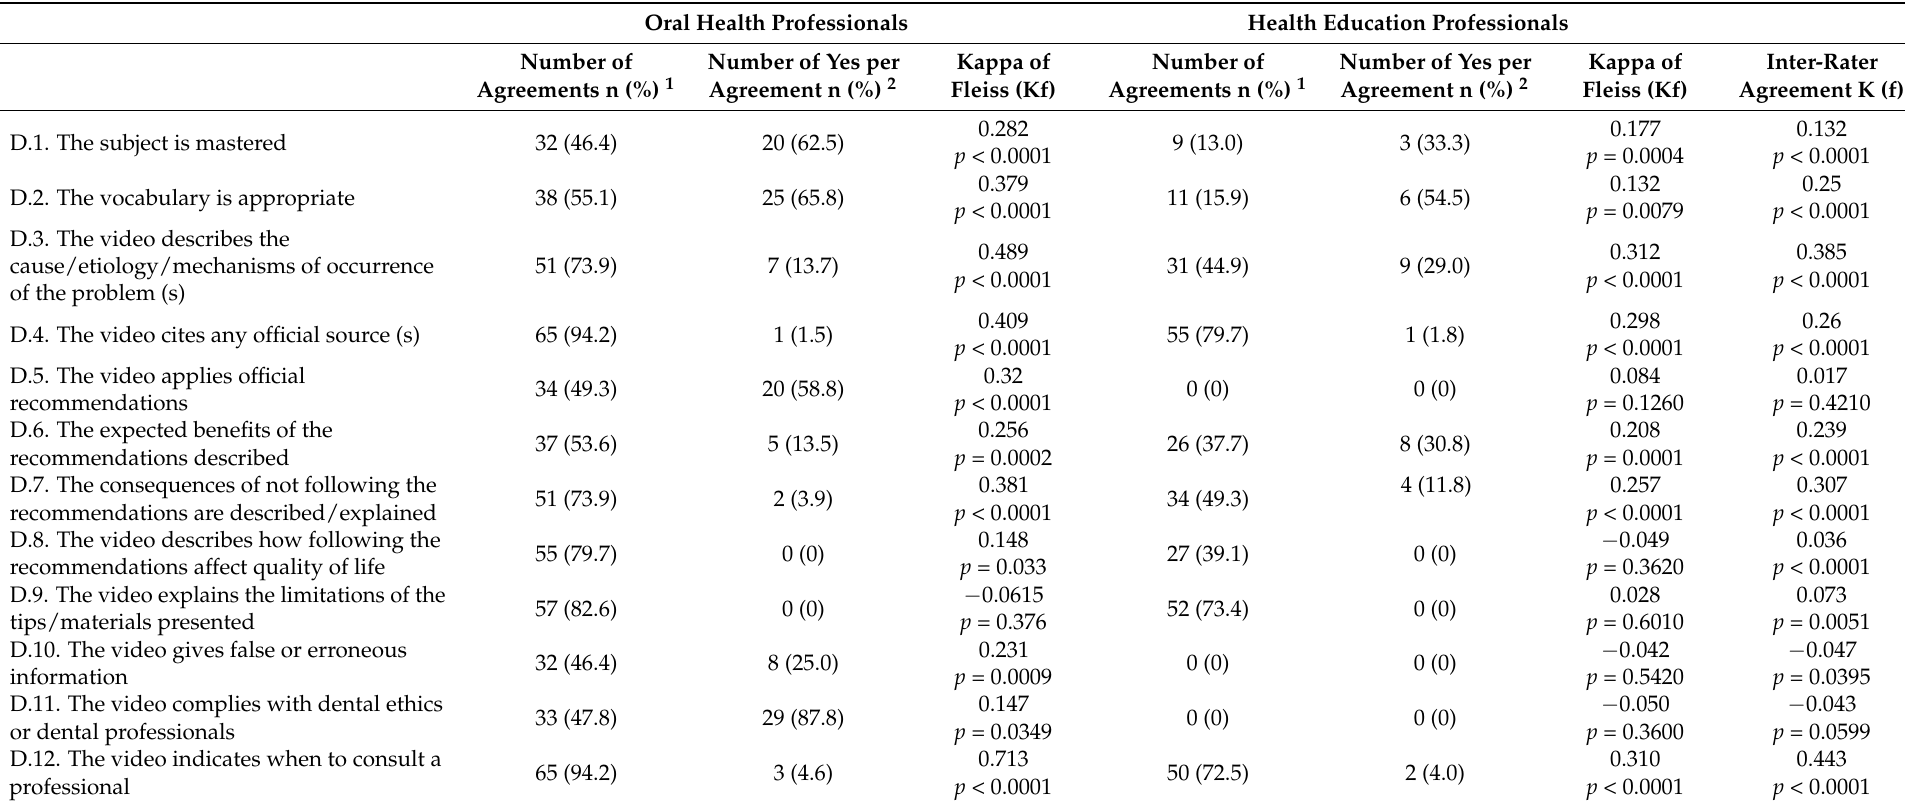
Table 5. Scientific or clinical basis of the message delivered by TikTok videos corresponding to